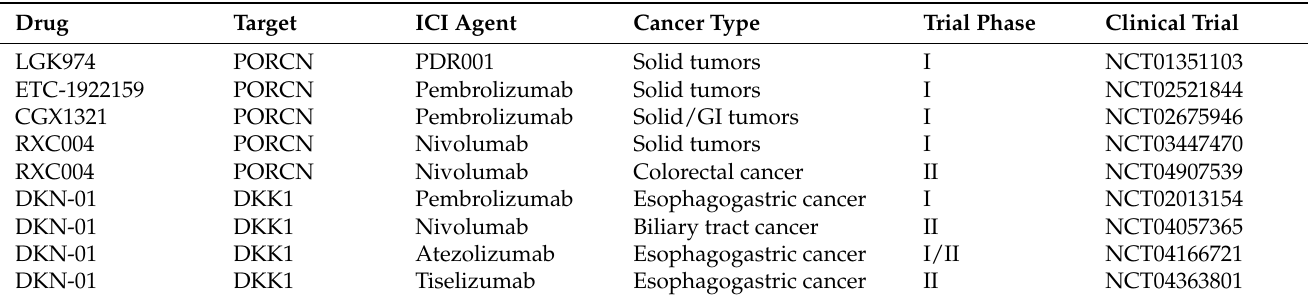
Table 2. Current clinical trials combining a Wnt/ β -catenin signaling inhibitor with an immune checkpoint